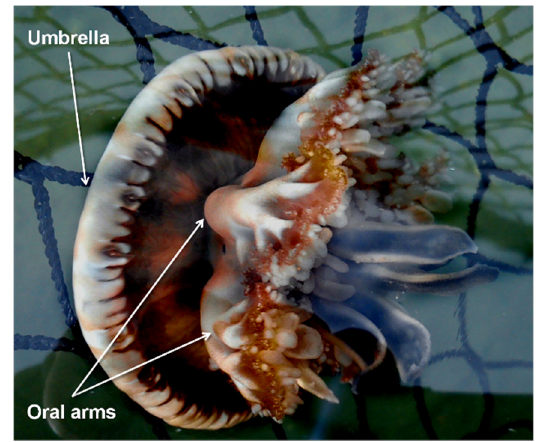
Figure 1. Cassiopea andromeda (Forsskål, 1775).